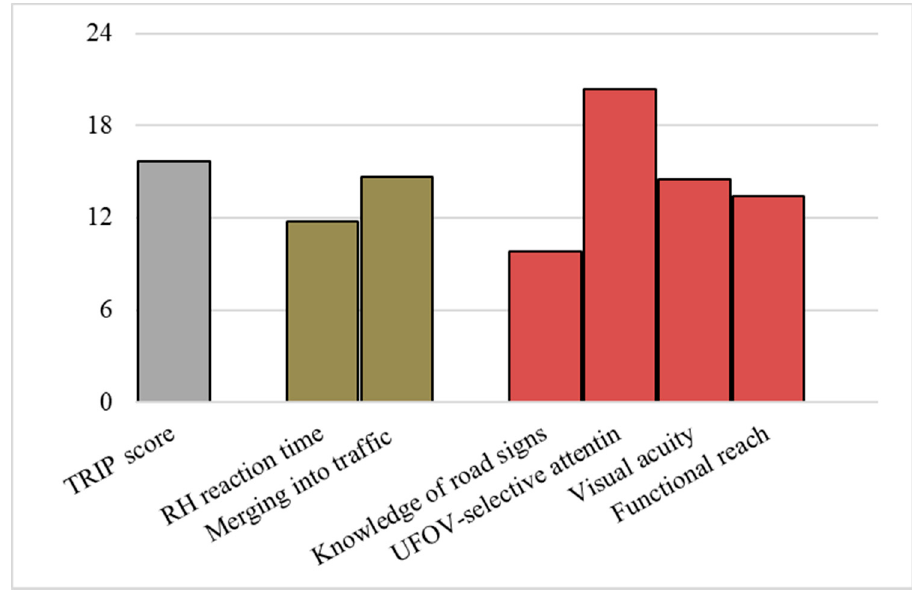
Figure 2. Relative importance of selected variables in the GBM model.